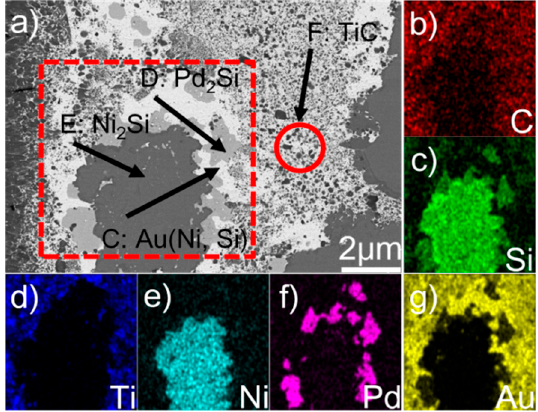
Figure 3. ( a ) BSE micrograph showing the detailed microstructure in the braze seam, and relevant elemental distribution of the red rectangle in ( a ): ( b ) C; ( c ) Si; ( d ) Ti; ( e ) Ni; ( f ) Pd; ( g ) Au.